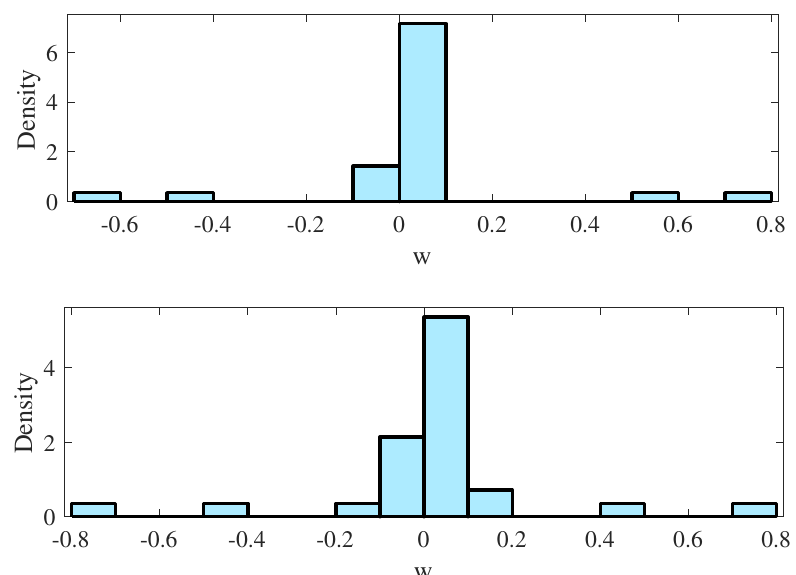
Figure 3. The distribution of w : the above is true w , the below is the estimated w model.